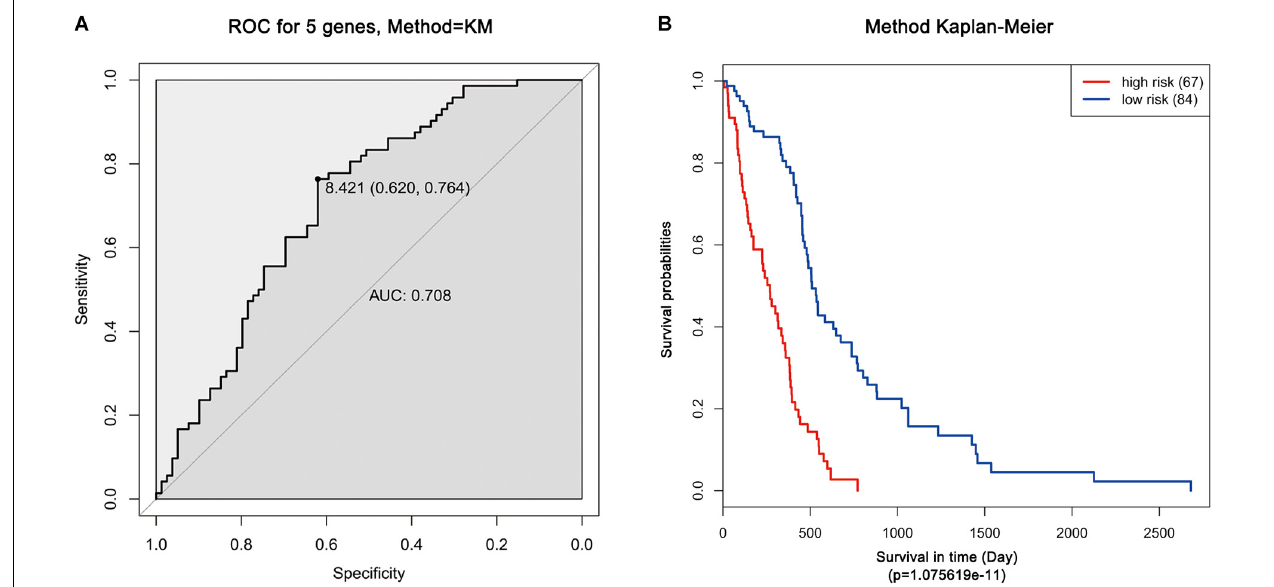
FIGURE 4 | ROC and Kaplan–Meier analysis of the five-gene signature in TCGA dataset. (A) ROC analysis of the sensitivity and specificity of the survival time according to the five-gene signature based on risk score. (B) Kaplan–Meier analysis of the five-gene signature based risk score. Patients were divided into low-risk and high-risk groups based on the optimal cut-off